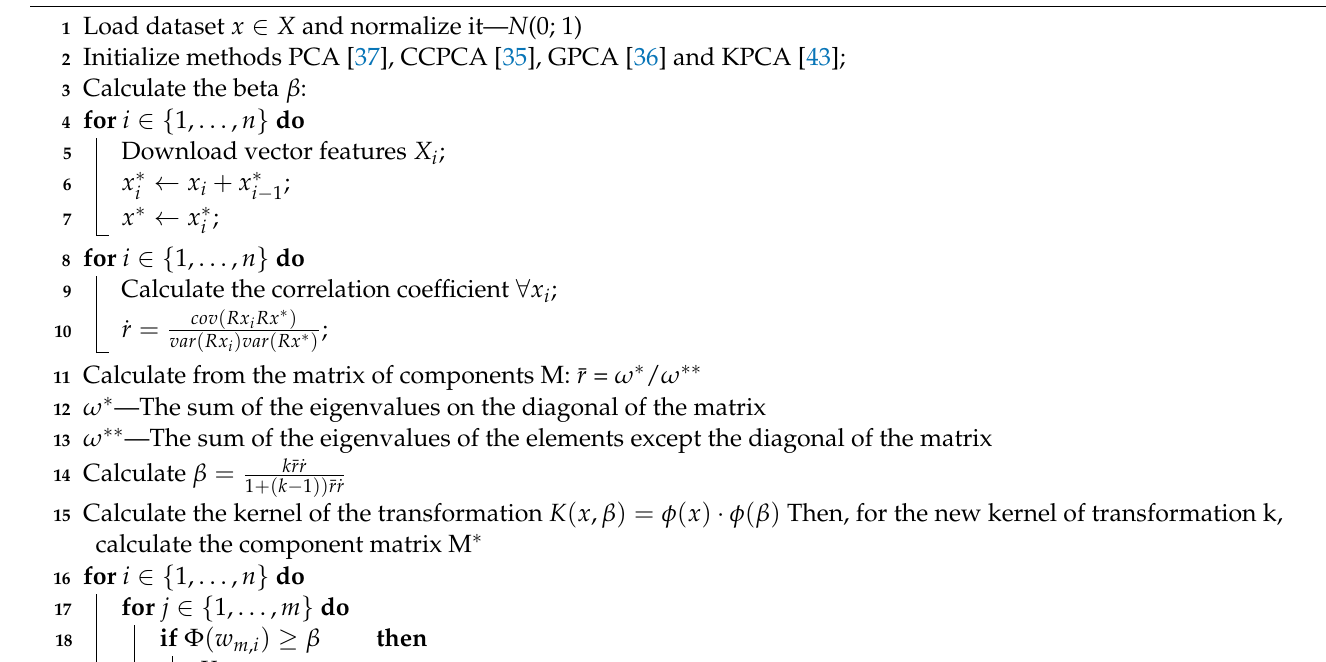
Algorithm 1: Model for determining the number of features n and components M